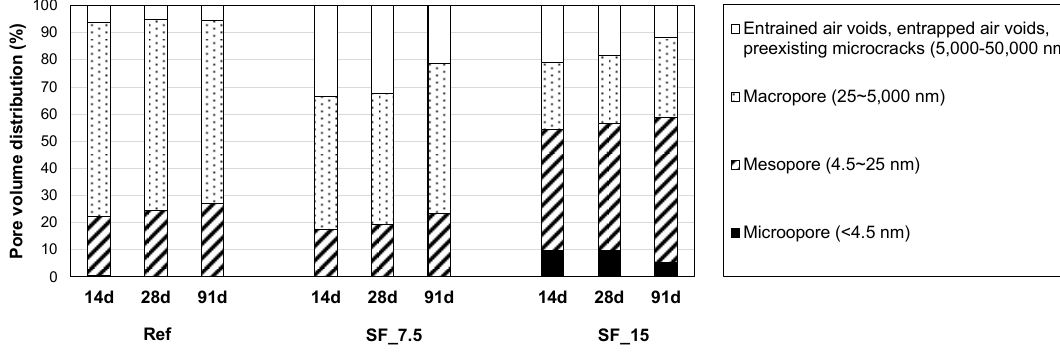
Figure 7. Pore volume distributions at different curing days.